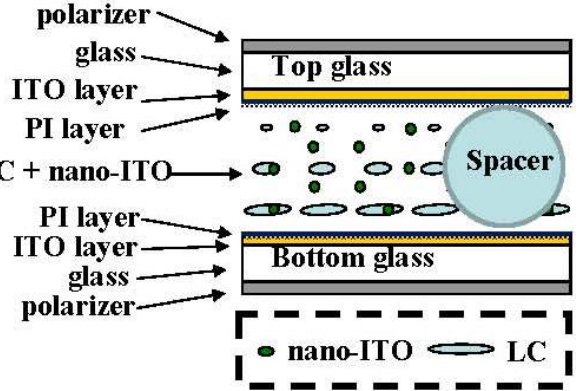
Figure 1. Structure of the display cell with the liquid crystal (LC) layer doped with tin-doped indium oxide (ITO)